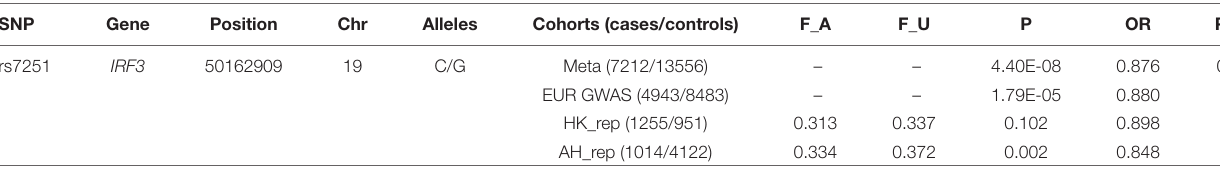
TABLE 1 | Summary statistics for rs7251 in discovery stage.